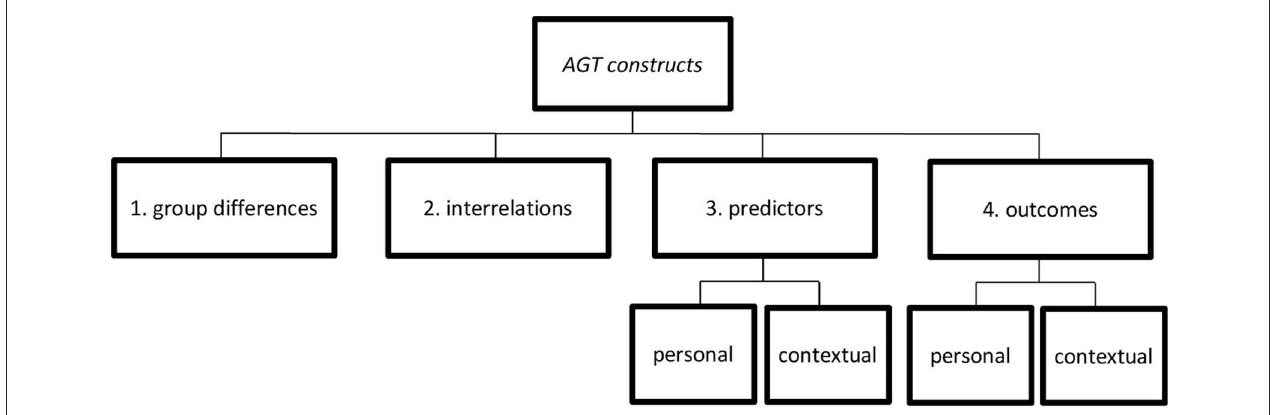
FIGURE 3 | Structuring categories for included observational studies. This figure depicts the different categories that were used in organizing the observational studies including group differences, interrelations, predictors, and